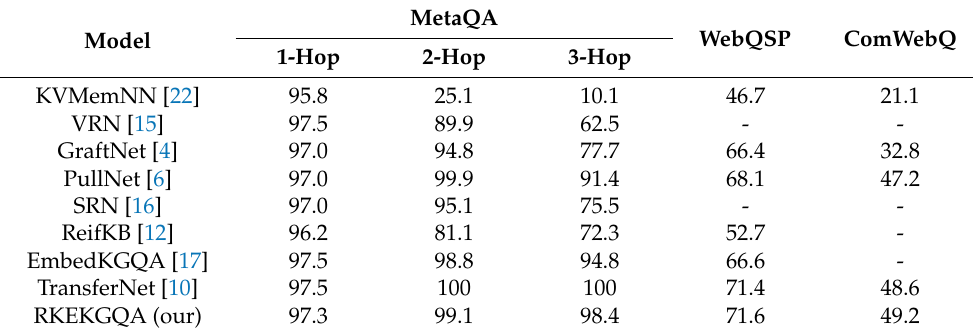
Table 4. Hit@1 results of the datasets.